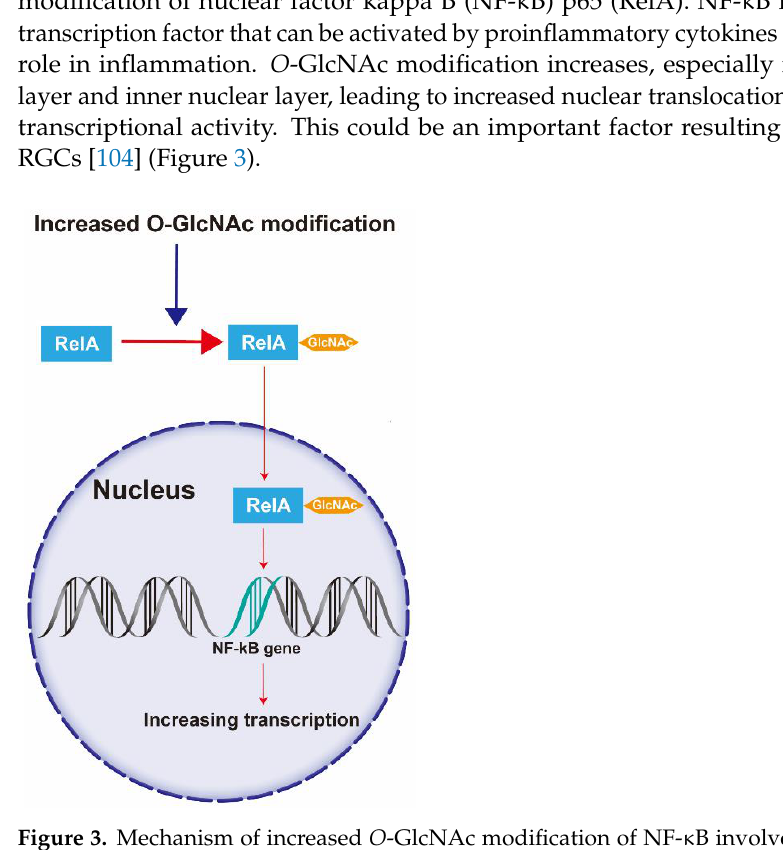
Figure 3. Mechanism of increased O -GlcNAc modification of NF- κ B involved in RGCs death. In- creased O -GlcNAc modification promotes NF- κ B transcriptional activity via its nuclear translocation, leading to RGC death. Abbreviations: NF- κ B, nuclear factor kappa B; RelA, nuclear factor kappa B p65.